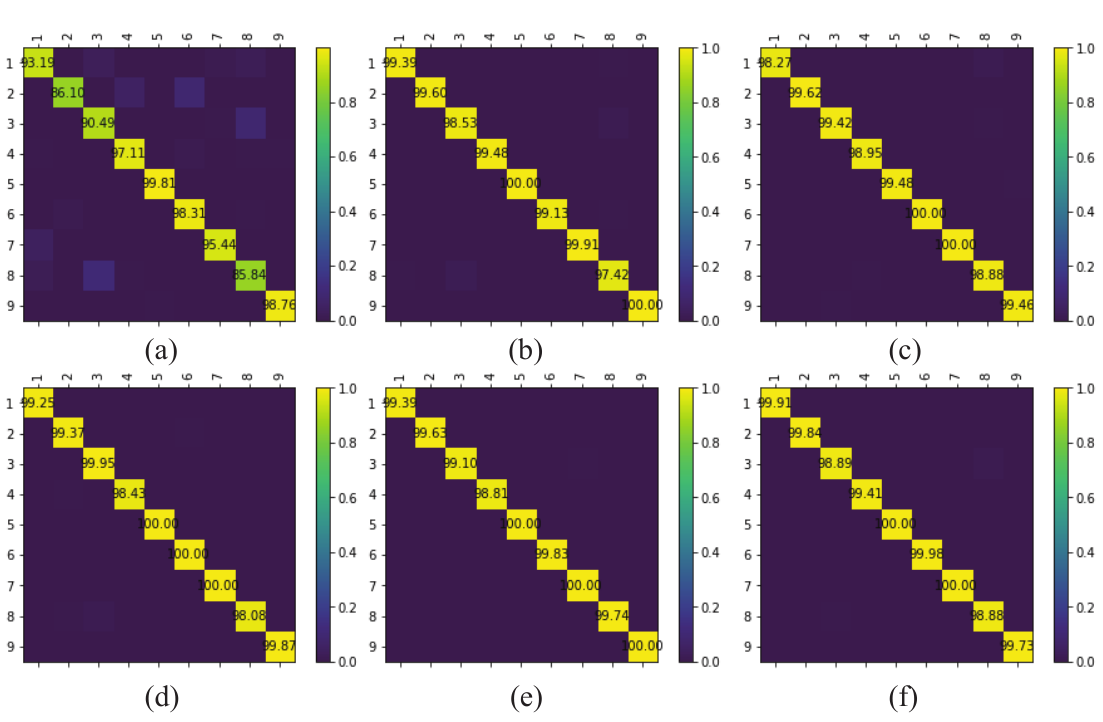
Figure 11. Normalized confusion matrices of classification results for the University of Pavia data set. ( a ) CNN. ( b ) M3DCNN. ( c ) SSRN. ( d ) MSDN-SA. ( e ) MSO3DCNN. ( f )